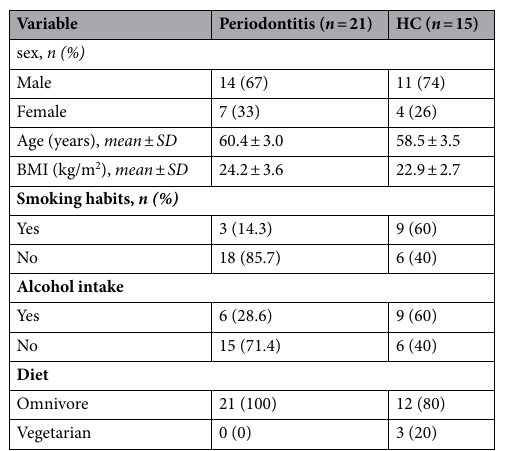
Table 3. Demographic characteristics of periodontitis and HC groups. Data are expressed as the mean ± standard deviation (SD) or number (n) and percentage (%). BMI, body mass